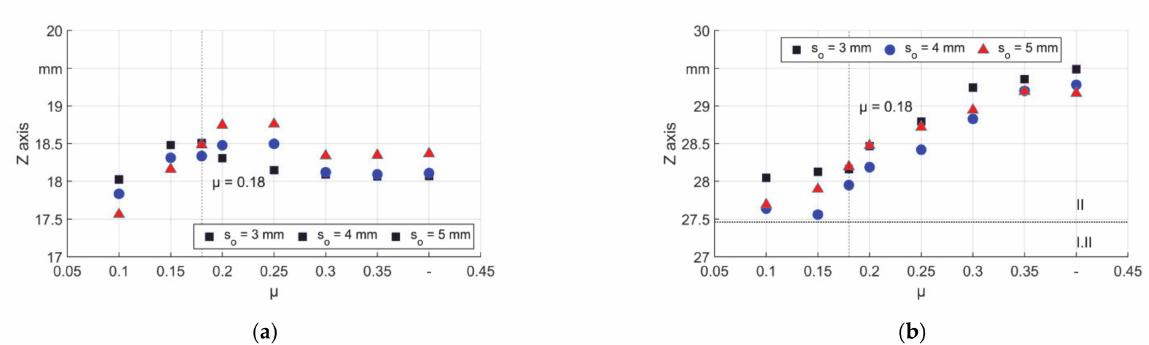
Figure 19. Barycenter of ∆ PE z peaks on the Z–axis, ( a ) Peak 1 and ( b ) Peak